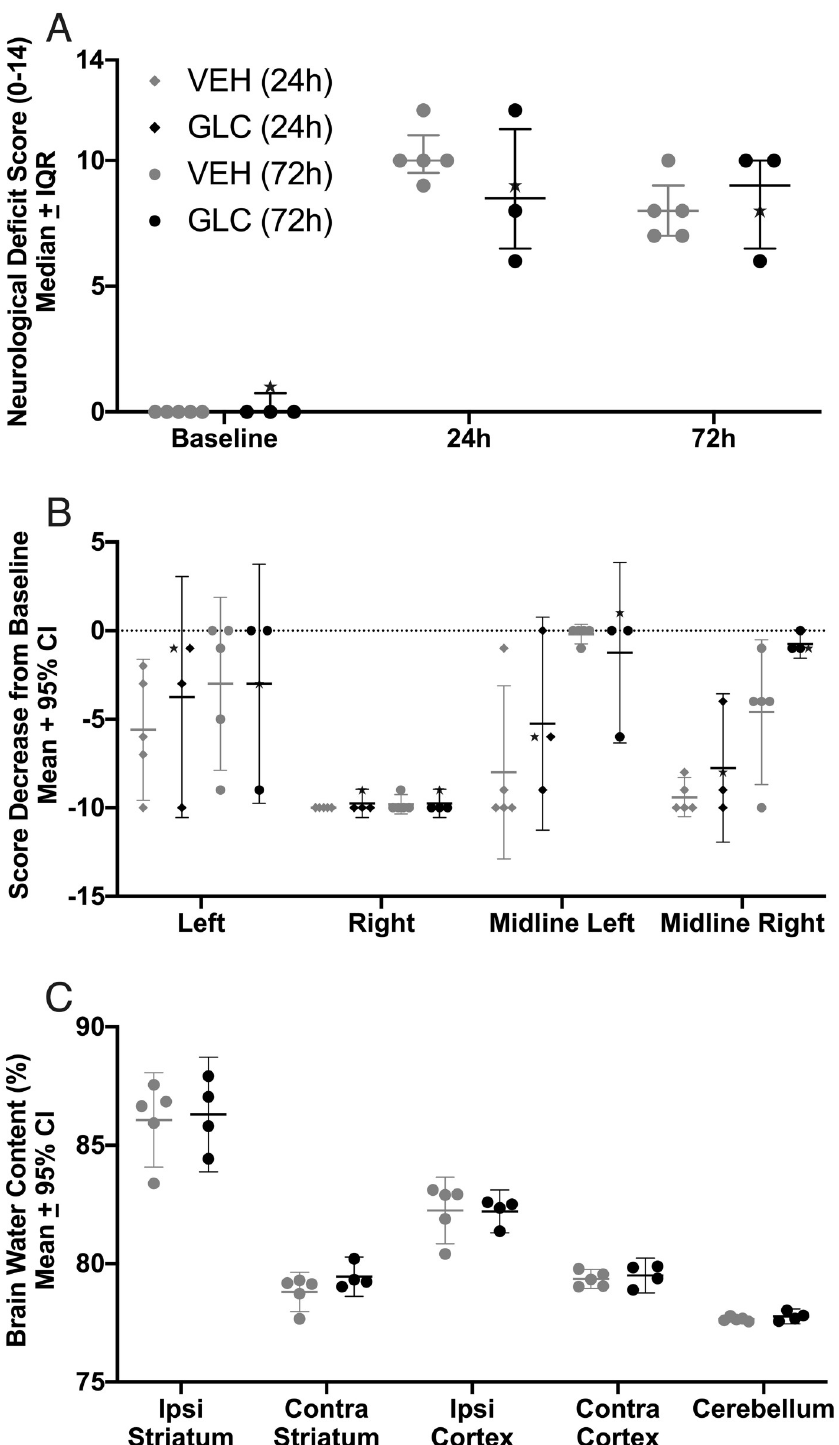
Fig 9. Experiment 4 edema at 72 h. ICH significantly worsened NDS performance (A, p < 0.0001 vs. baseline, Cohen’s d z = 8.2 at 24 h, Cohen’s d = 45.2 at 72 h) and all forelimb placing at 24 h (B, p � 0.0125 vs. baseline, Cohen’s d z = 3.5), for which the left forelimb deficits had resolved by 72 h (left and midline left, p � 0.107) but were still present in the right forelimb (right and midline right, p � 0.0415, Cohen’s d = 1.3). For forelimb placing, the dashed line at 0 denotes no impairment. No meaningful benefit of glibenclamide was found on either NDS (p � 0.2063), or forelimb placing of